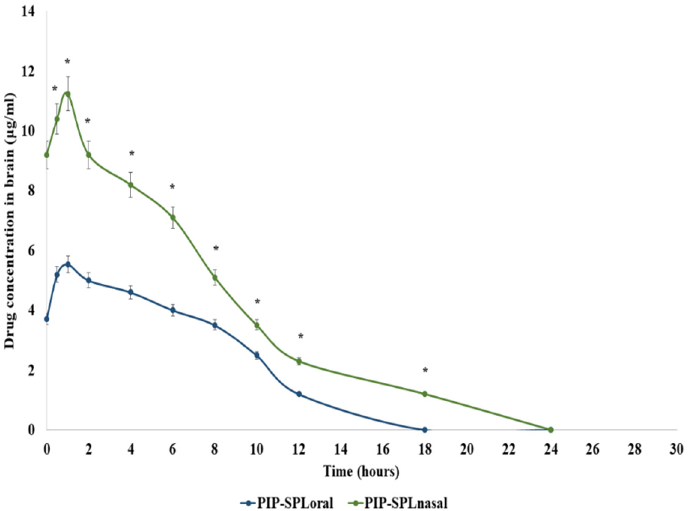
Figure 8. Plasma drug concentration profiles of piperine after oral and intranasal delivery. *: statis- tically significant at p ≤ 0.01.